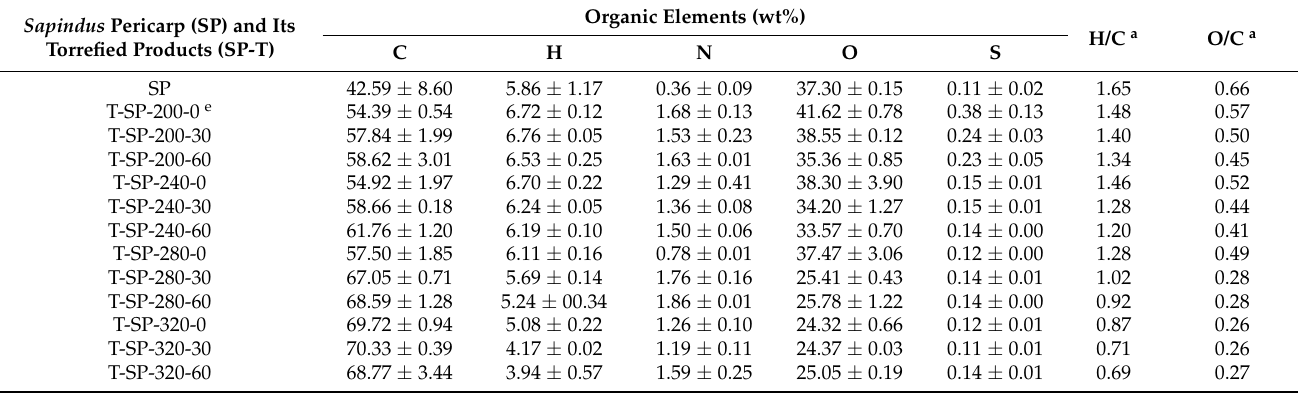
Table 3, the calorific values of the SP-torrefied products can be further estimated by using the commonly used equations like Dulong’s formula [27]. It can be found that the calorific values were closely equal to those determined by the calorimeter instrument (Table 2). Table 3. Organic elements of Sapindus pericarp (SP) and its torrefied products produced at different torrefaction temperatures (200–320 ◦ C) and residence times (0–60 min). Organic Elements (wt%) Sapindus Pericarp (SP) and Its Torrefied Products (SP-T)